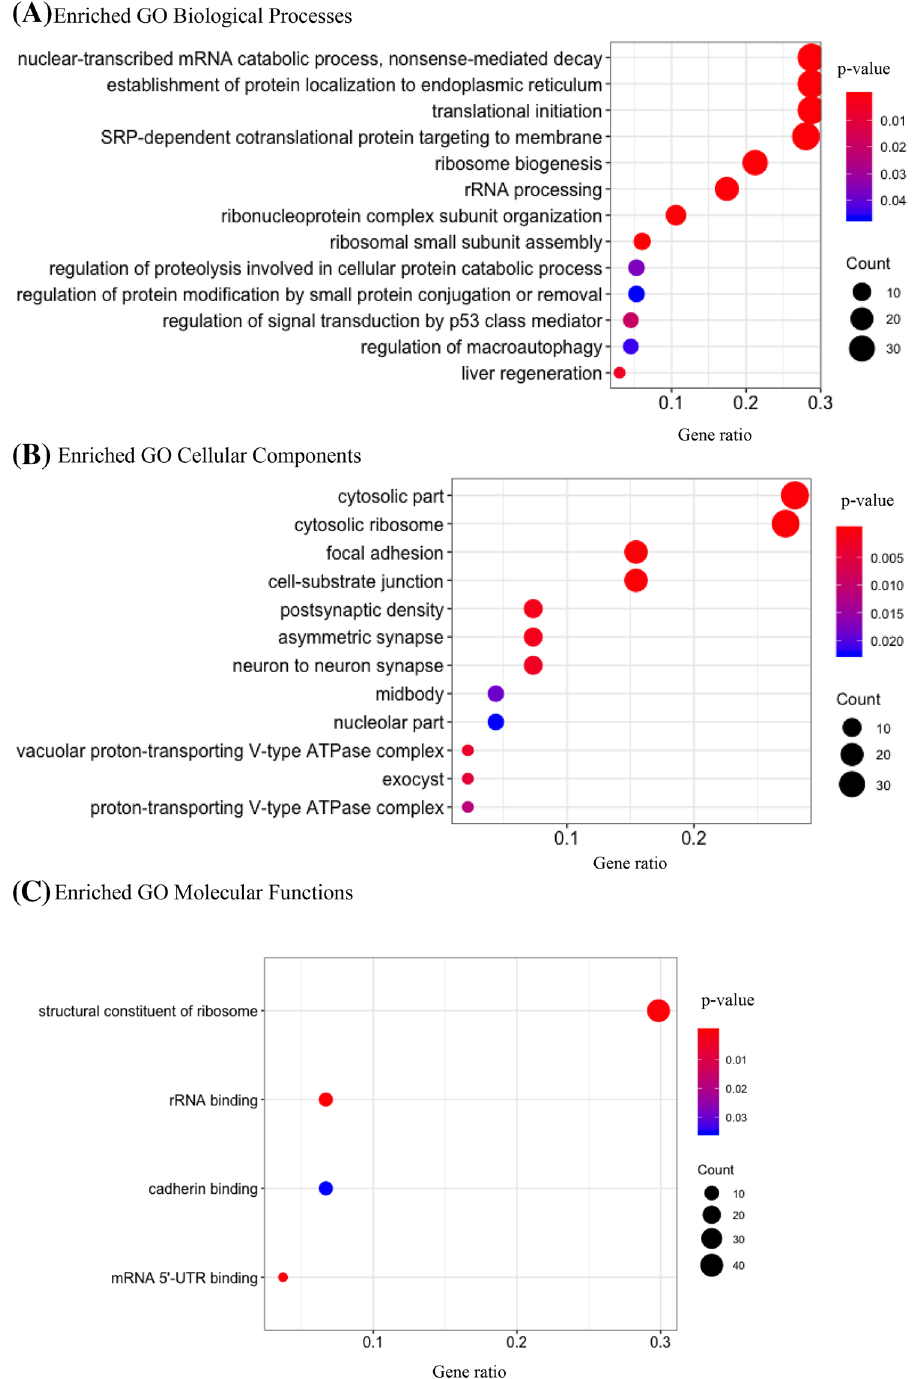
Figure 1. GO enrichment analysis using high throughput co-complex interaction annotations for ( A ) biological processes, ( B ) cellular components, ( C ) molecular functions. For each plot, Y-axis represents a significant GO definition, and X-axis represents the counts of enriched genes (Gene ratio). The gradient of color represents the different p -values, and size of the dot represents the count number of genes in each GO